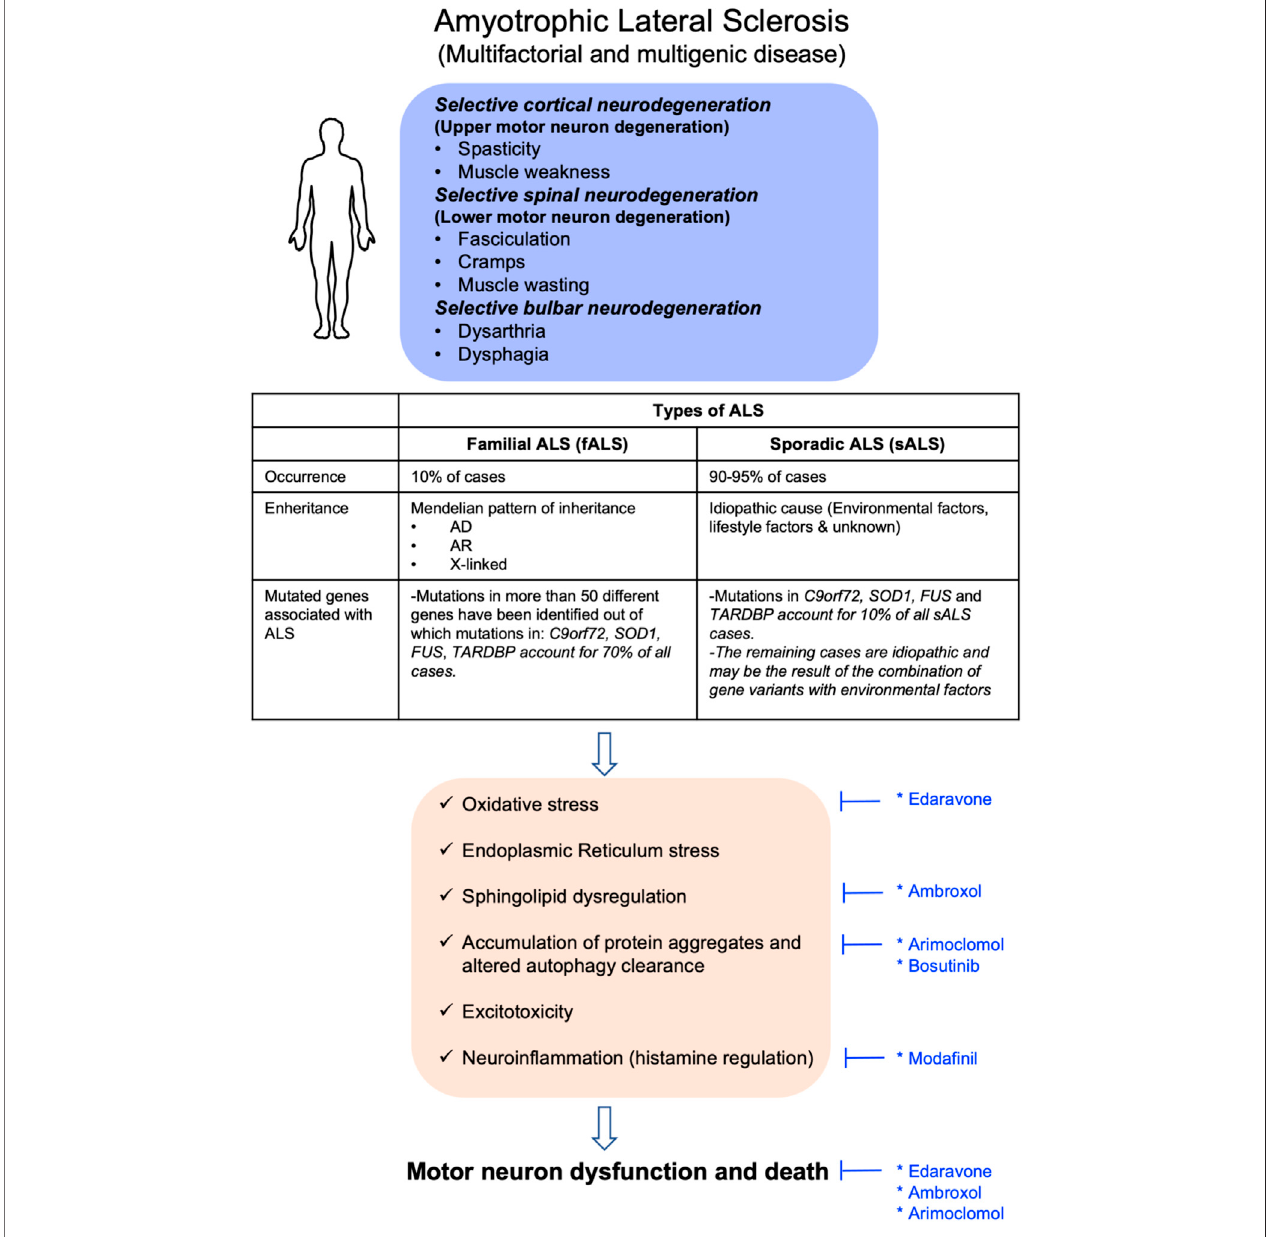
FIGURE 4 | Clinical manifestations and molecular disease mechanisms in amyotrophic lateral sclerosis. This pathology may have familial origin (fALS) or sporadic origin(sALS). The fi rsthasMendelianinheritance, whilethesecondhasmostlyidiopathic causes.Inboth forms ofALS, diverse cellular alterations existresultinginmotor neuron dysfunction and death which cause the clinical manifestations of the disease. Repurposed drugs with and without orphan designation for ALS are highlighted in blue along with the cellular dysfunctions or clinical manifestations that they tackle. AD, autosomal dominant; AR, autosomal recessive; C9orf72, gene encoding guanine nucleotide exchange; FUS , gene encoding the RNA-binding protein FUS; SOD1, gene encoding superoxide dismutase 1; and TARDBP, gene encoding TAR DNA-binding protein 43, TDP43.